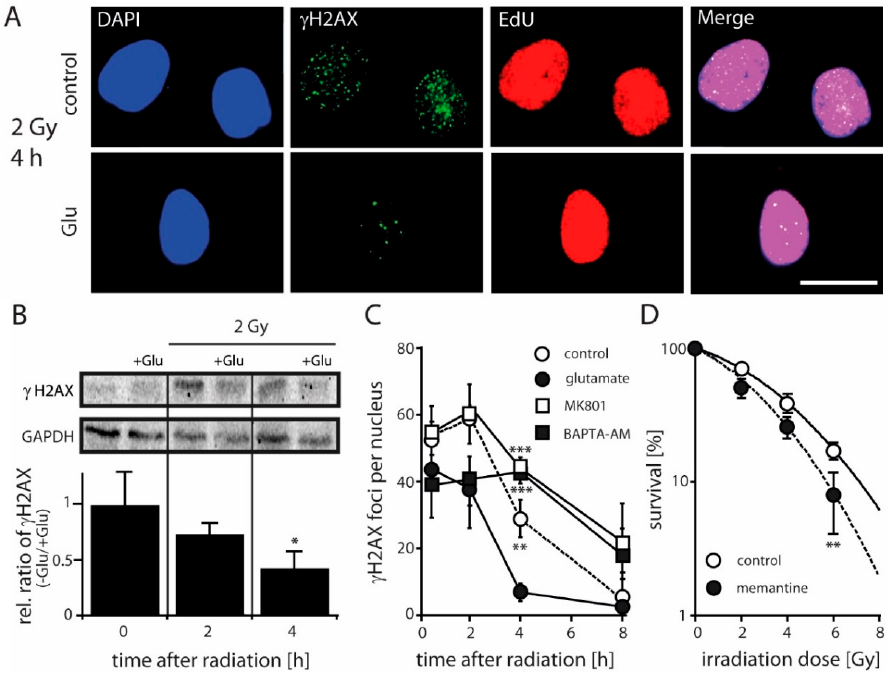
Figure 3. Effect of glutamate on DSB repair and clonogenic survival of LN229 cells. ( A ) Figure 3. E ff ect of glutamate on DSB repair and clonogenic survival of LN229 Immunofluorescence of γ H2AX, EdU and DAPI from Glu-treated and untreated cells 4 h after irradiation (2 Gy). Note that addition of Glu (1 mM) resulted in a significant decrease in DSB levels